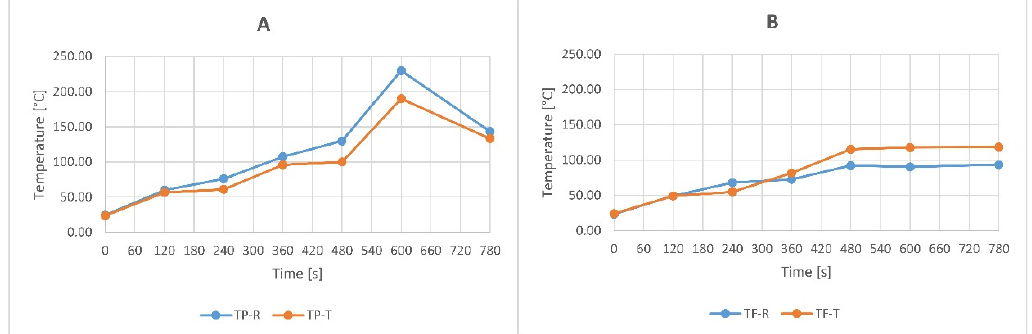
Figure 7. Average temperatures on the specimen surface during the experiment. ( A ) samples TP − R and TP − T; ( B ) Samples TF − R and TF − T. Table 7. Average specimen densities (kg·m − 3 ).